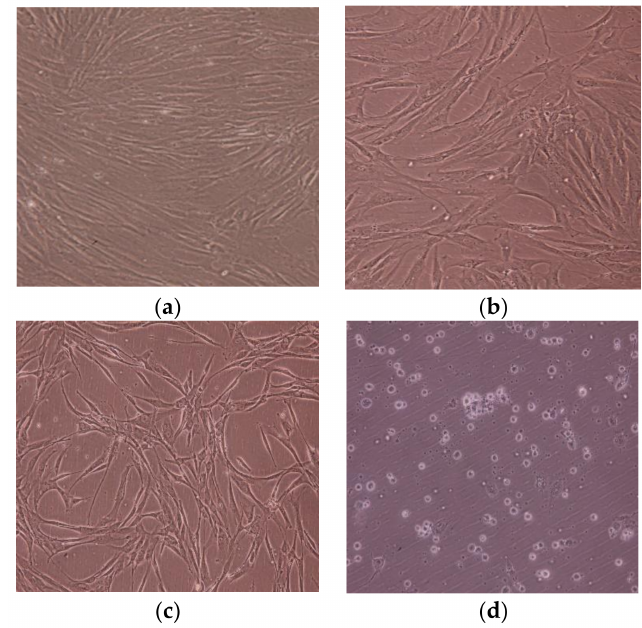
Figure 14. HSF cell growth in the ( a ) extraction medium and on the surface of the ( b ) Ti (uncoated) sample, ( c ) TiV coating, and ( d ) 700 ◦ C HTA Ti-V-O